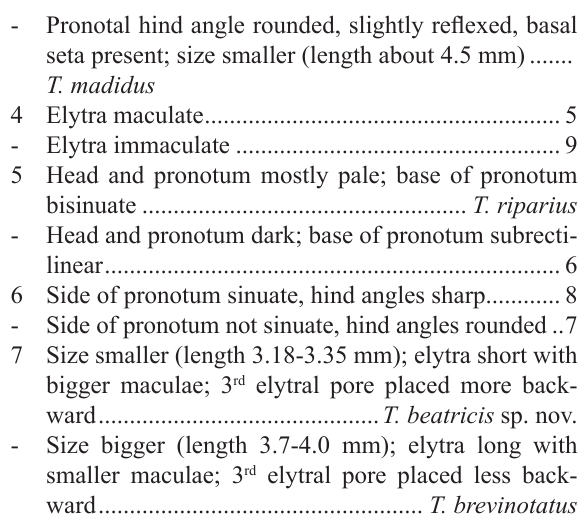
Map 4 - Collection sites for Pterocyrtus